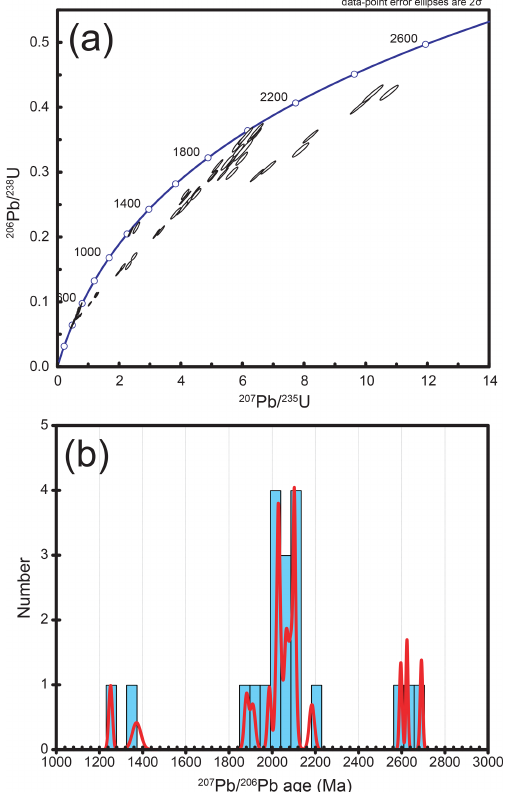
Figure 9. Concordia plot (a) including all zircon with concordance > 90% from sample JBP-71-15 (Sobrado migmatitic paragneiss) and (b) age histogram and probability density plot for ages older than 1000Ma.